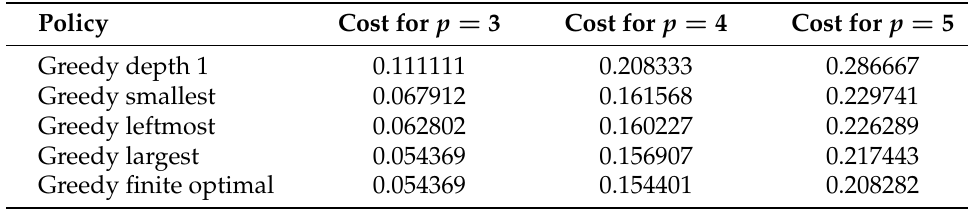
Table 3. Average cost of different greedy